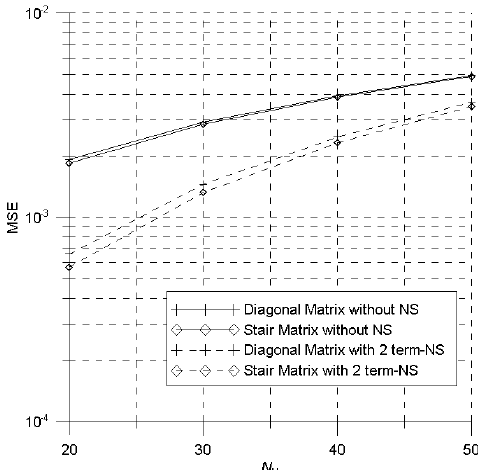
Figure 3. The mean square error (MSE) performances between ZF pre-coding symbols and GS pre-coding symbols with respect to different initial solutions.